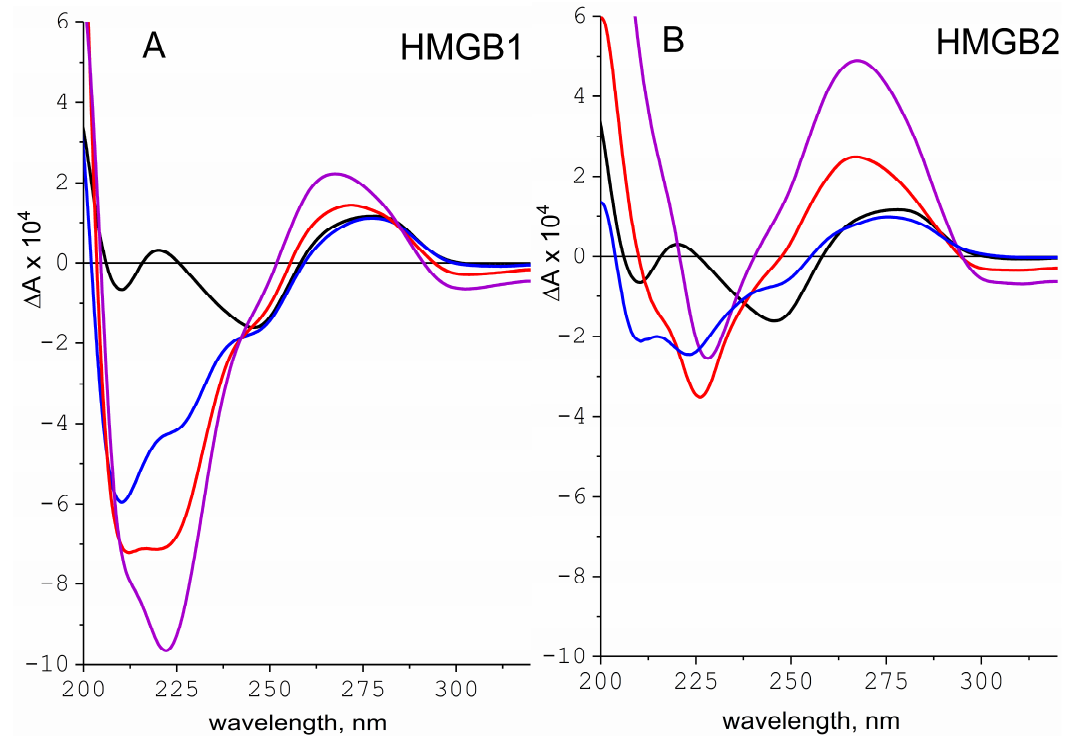
Figure 4. CD spectra of complexes HMGB1/DNA ( A ) and HMGB2/DNA ( B ) at different pro- tein/DNA ratios in 15 mM NaCl. CD spectra of protein/DNA complexes at protein/DNA weight ratios r 0.5 (blue), 0.75 (red), and 1.0 (violet); DNA (black) in a 15 mM NaCl solution. The obtained CD spectra are presented as the difference between the absorptions of left- and right-polarized light ∆ A ( ∆ A = A L − A R ). At the same protein/DNA ratios, the CD spectra of the complexes are remarkably different. The shape of the CD spectra in the HMGB2/DNA complex indicates the presence of light scattering already at r = 0.75, which is typical for the formation of large supramolecular particles in solution, while for the HMGB1/DNA complexes, similar changes in the spectrum occur at r > 1.